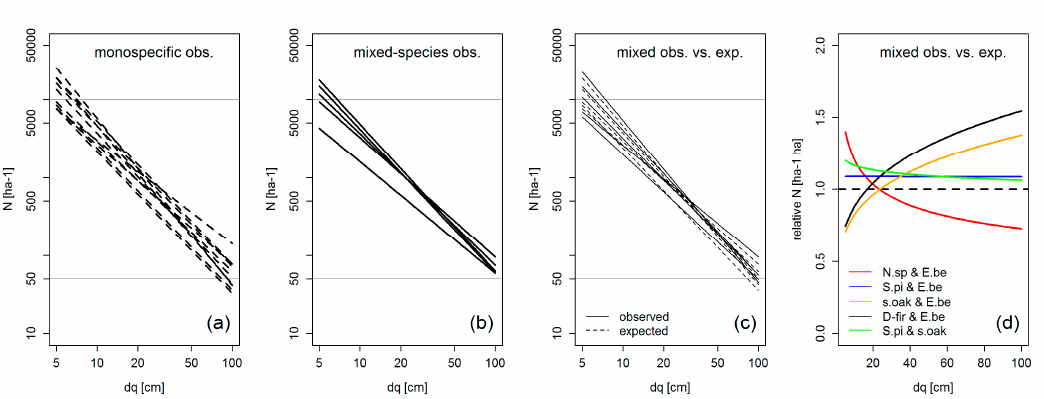
Figure 16. Self-thinning lines in mixed compared with monospecific stands of Norway spruce and European beech, Scots pine and European beech, sessile oak and European beech, Douglas-fir and European beech, and Scots pine and sessile oak. ( a ) Self-thinning lines of monospecific stands, ( b ) more shallow self-thinning lines of neighboring mixed-species stands, ( c ) standardized, observed versus expected self-thinning lines for mixed stands, and ( d ) standardized, observed compared with expected tree numbers (1.0-line) in mixed-species stands (see Table 1, model 10). Forests 2019 , 10 , x FOR PEER REVIEW We found that by some tree species combinations, the maximum stand density can be reduced; for others, it can be considerably increased by mixing. The consequences for deriving maximum stand density, density regulation and development of silvicultural guidelines are demonstrated for three selected mixtures in Figure 17.